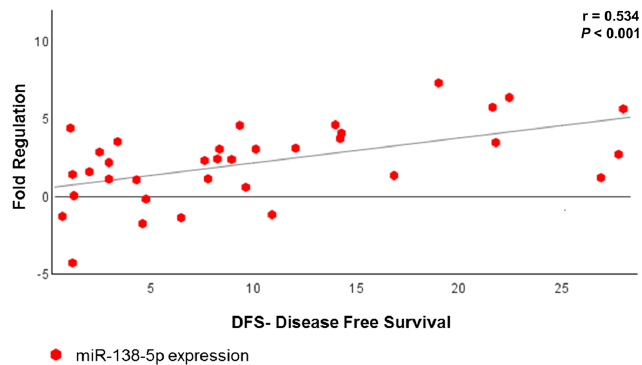
Figure 7. Scatter plot showing the association between miR-138-5p expression and DFS in all US patients who underwent adjuvant treatment.